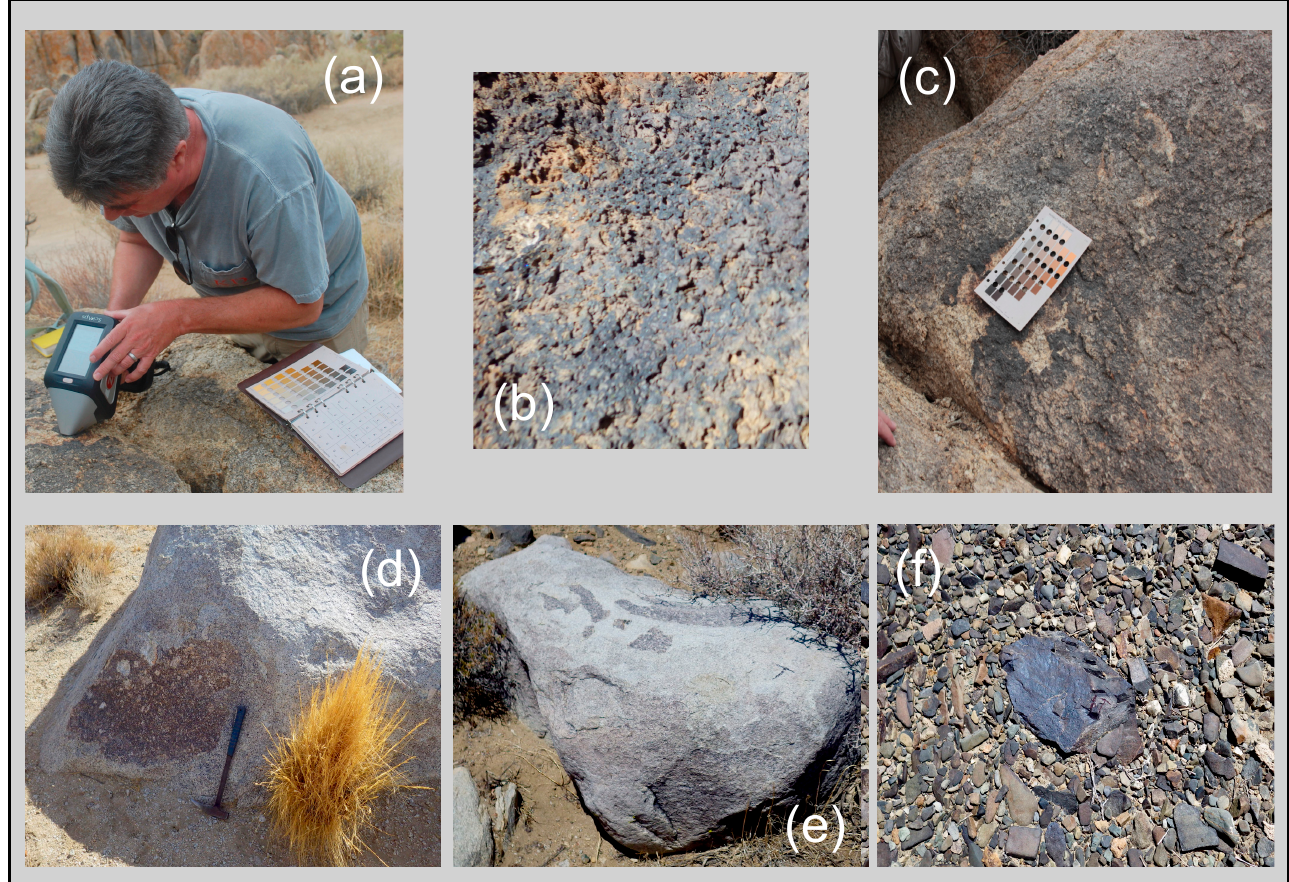
Figure 4. ( a ) Typical use of handheld LIBS during fieldwork. ( b ) Discontinuous varnish on basalt at Fossil Falls, Owens Valley. ( c ) Desert varnish on a granite outcrop, Alabama Hills, Owens Valley. Residual desert varnish “patches” on granite boulders on the ( d ) Lone Pine and ( e ) Fish Springs alluvial fans of Owens Valley. ( f ) Strongly varnished clasts in the desert pavement on an alluvial terrace in Deep Springs Valley.